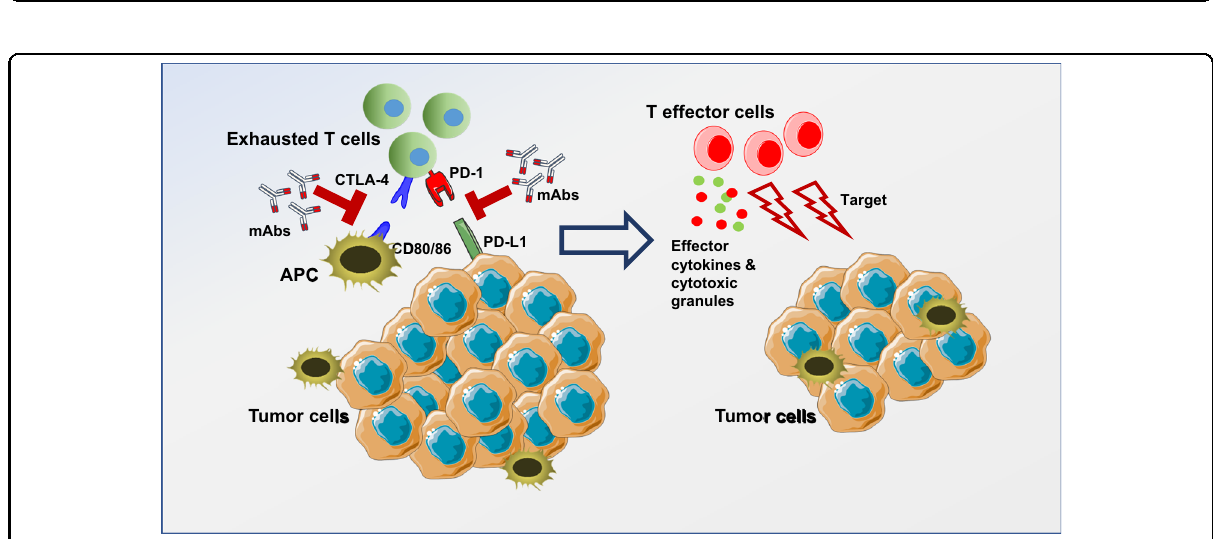
Fig. 2 Immune checkpoint blockade for T-cell activation. Immune checkpoints, including PD-1 and CTLA-4, expressed on activated T cells lead to inhibition of T-cell activation upon binding to their ligands on tumor cells/antigen-presenting cells. These interactions can be blocked using monoclonal antibodies, leading to the activation of T cells targeting tumor cells through the release of effector cytokines and cytotoxic